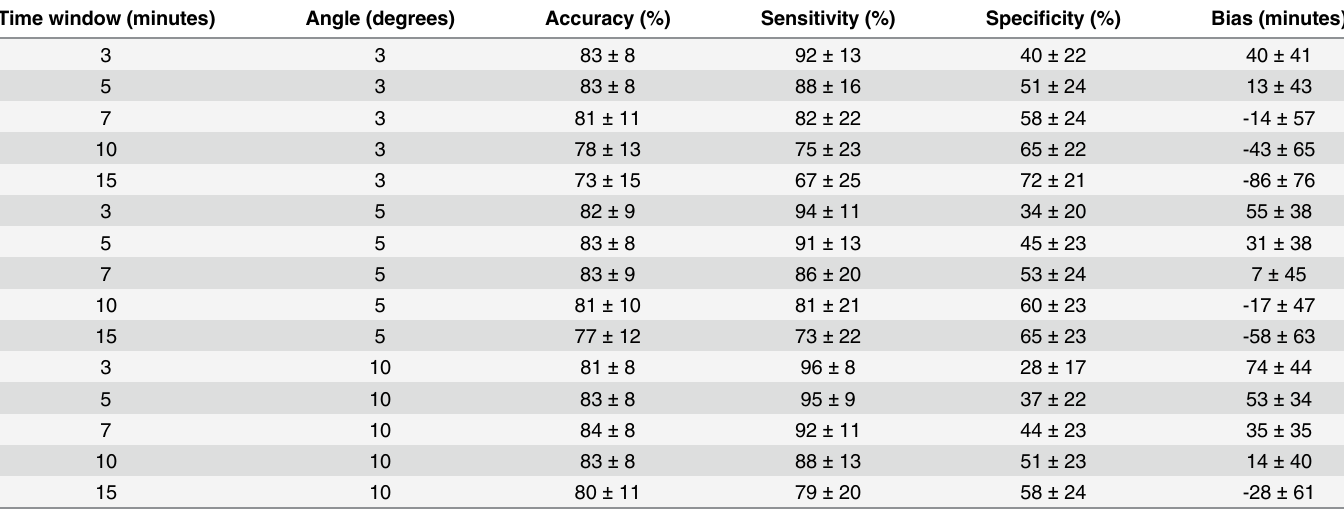
Table 3. Classification agreement between accelerometer and